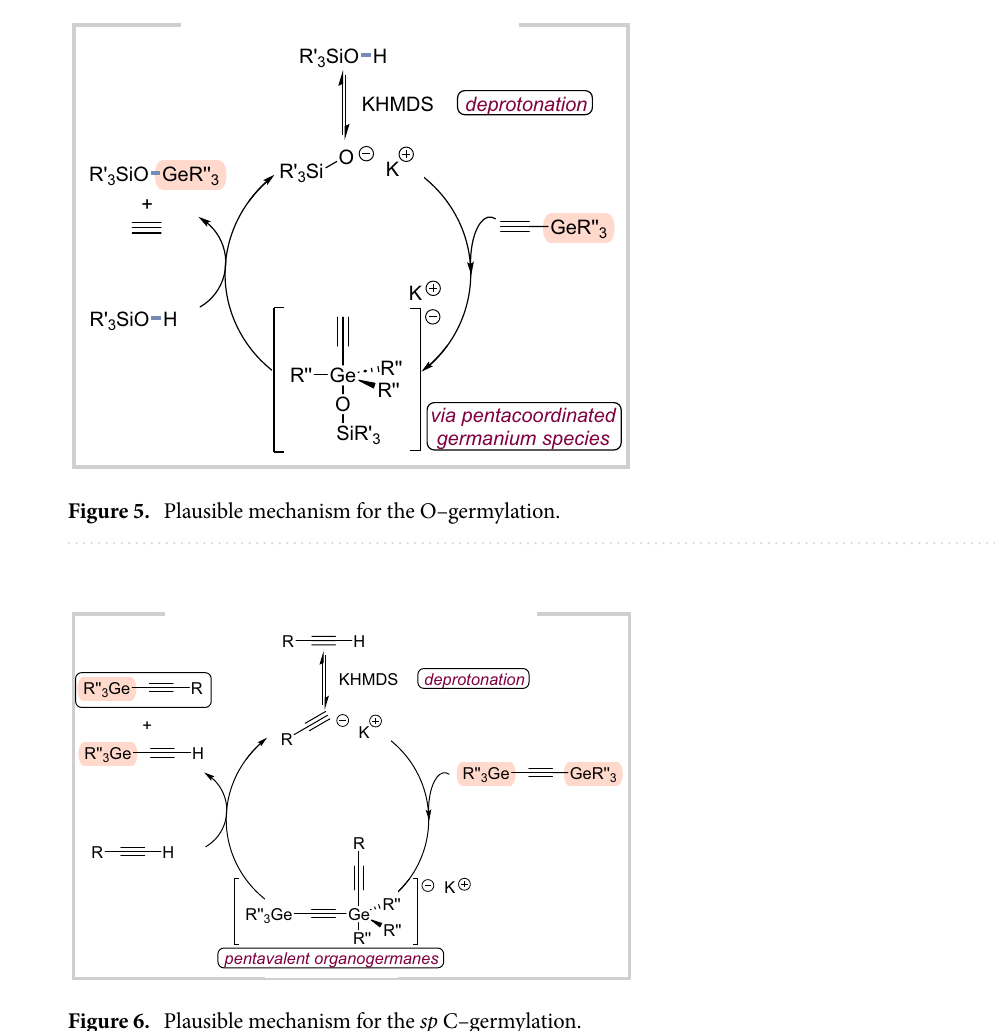
Figure 6. Plausible mechanism for the sp